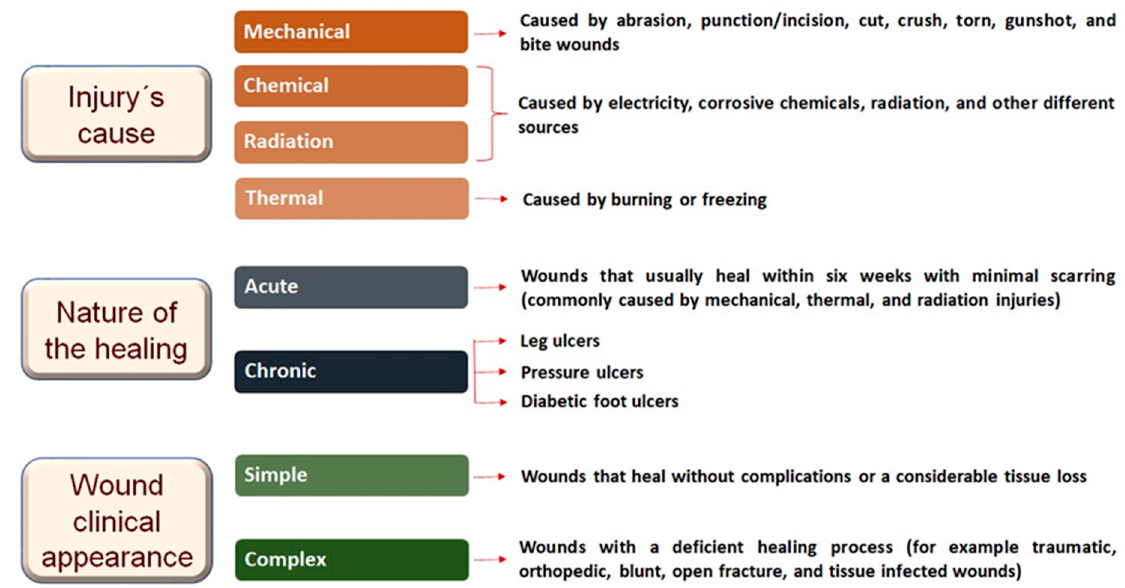
Figure 1. Flow diagram of wound classification.